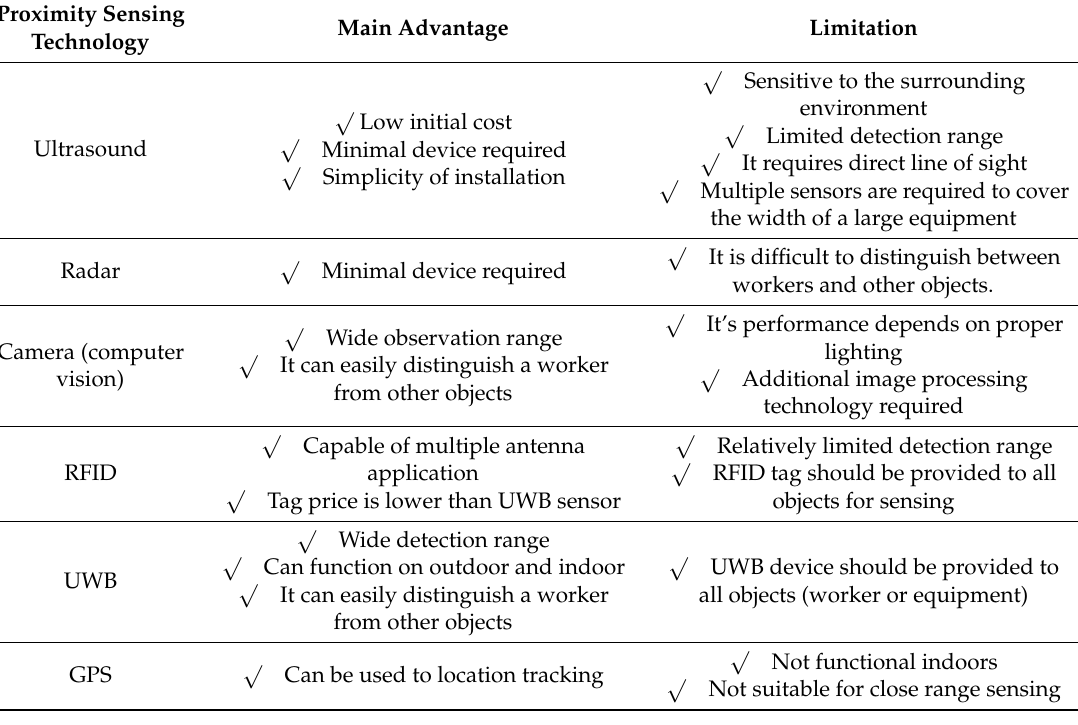
Table 1. Advantages and limitations of proximity sensing technologies